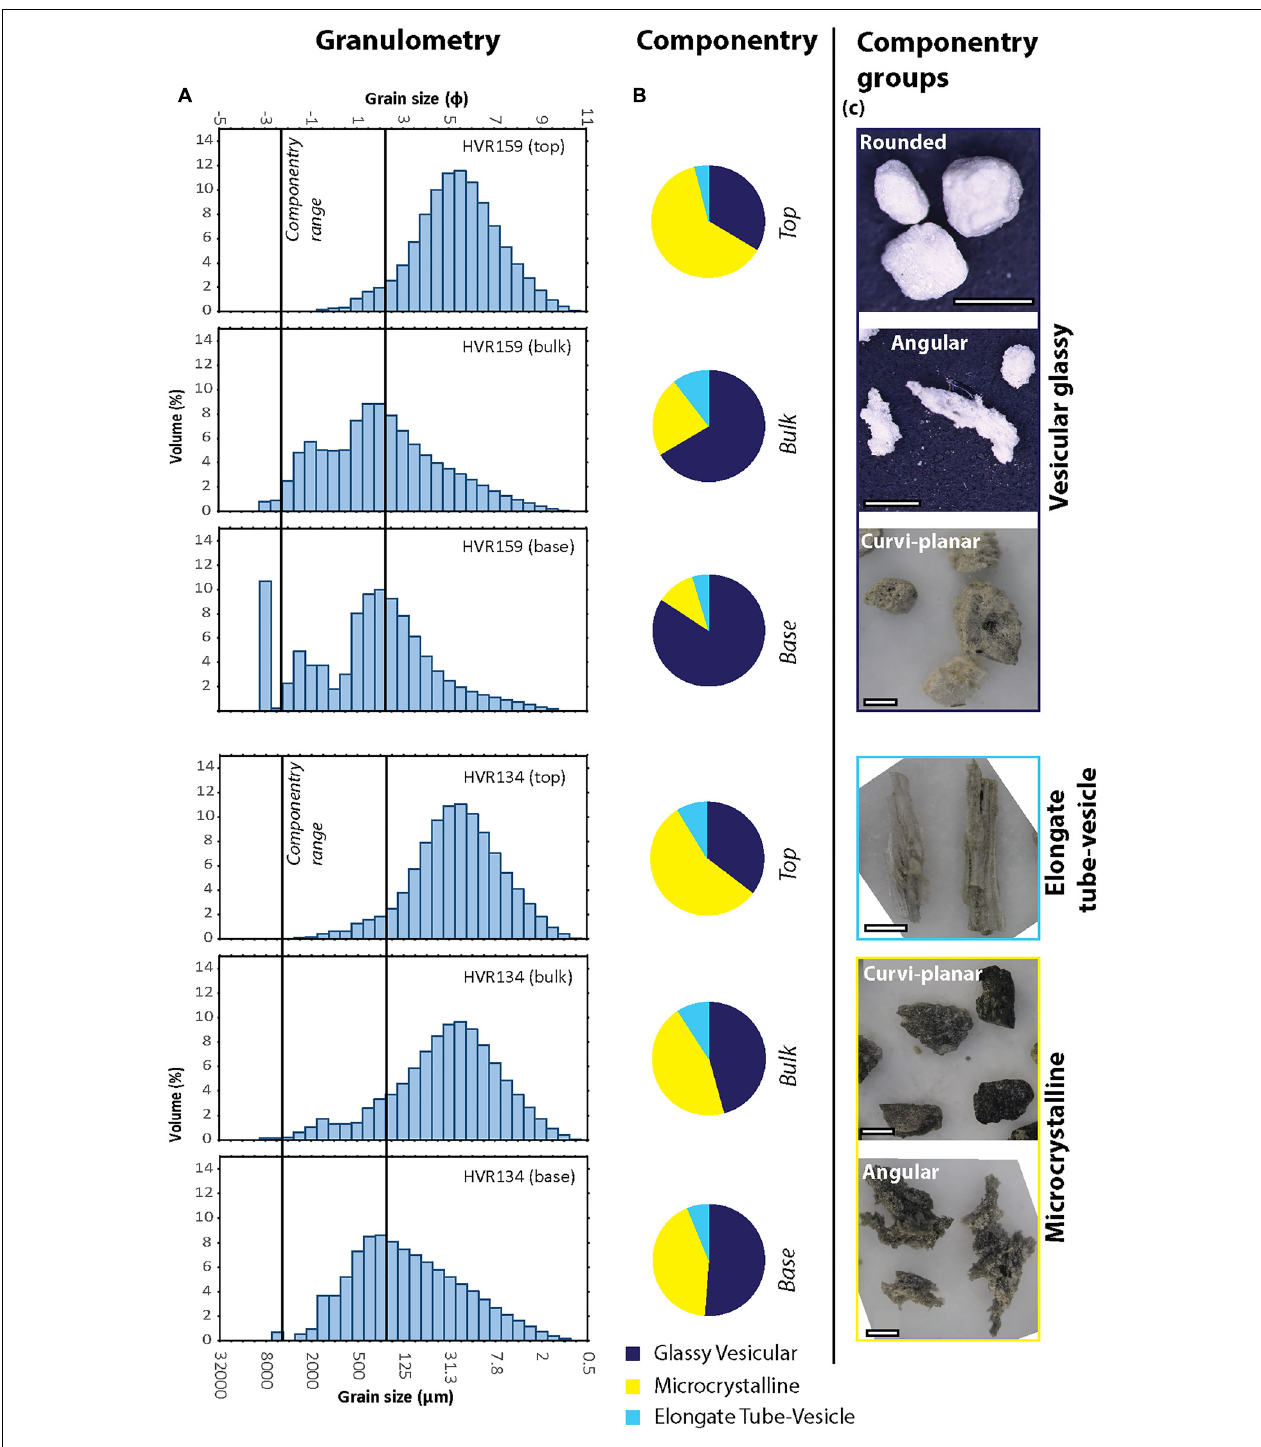
FIGURE 3 | Grainsize distribution (a) and componentry (b) for samples HVR159 mixed, HVR134 mixed, and their basal and upper layer subsamples. The upper sub-sample is finer grained, shows a decrease in glassy vesicular particles, and a concurrent increase in microcrystalline particles from its bottom to top. In the mixed sample, there is a concentration of elongate tube-vesicle particles. Componentry range indicated for both samples. Small subsamples removed from mixed samples ( < 5% mixed-sample mass) slightly reduce measured proportions of subsampled ash in mixed samples. (c) Optical images that show the componentry classes and their morphological subclasses. Color differences in particles are due to groundmass microcrystallinity, where microcrystalline particles show a higher crystallinity than glassy vesicular, and elongate tube-vesicle particles.